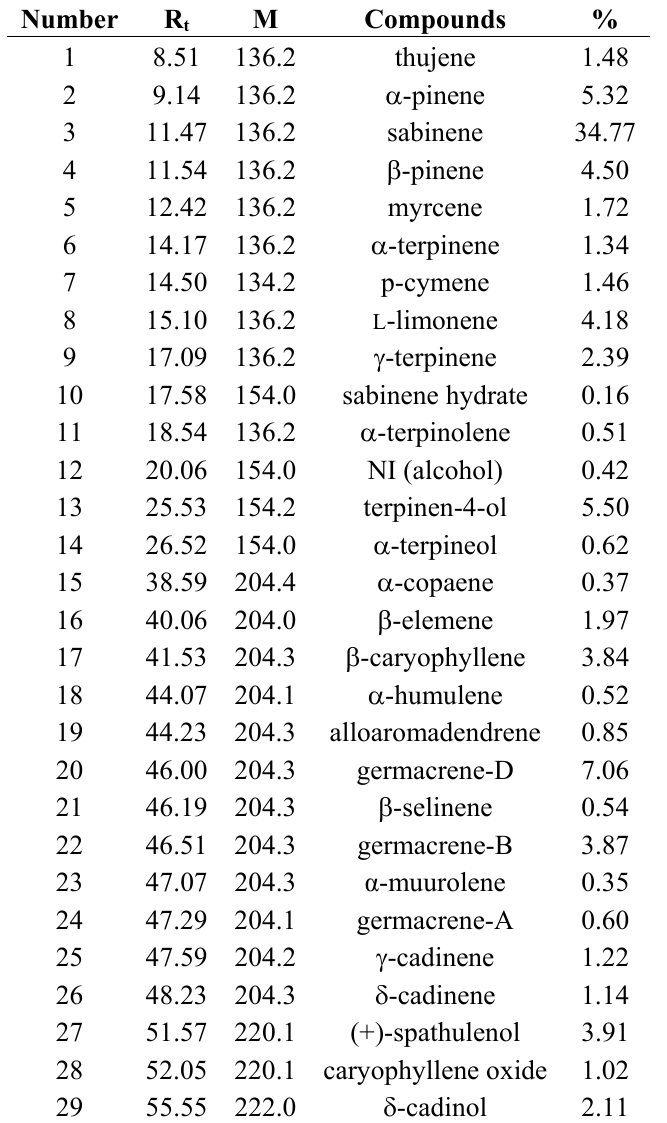
Table 1. Components and quantification of the essential oils of fruits and leaves of S. molle